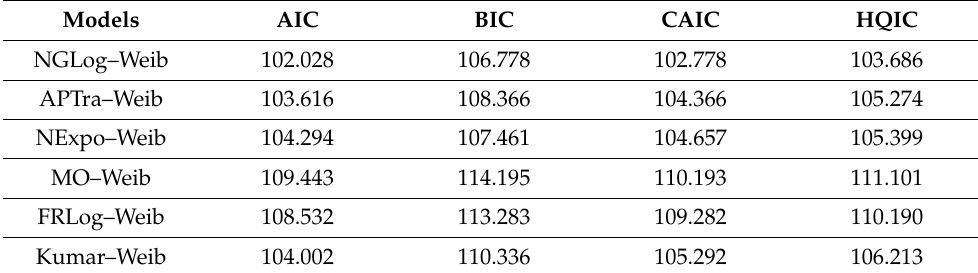
Table 14. The DMs of the competing models for COVID-19 data (dataset 3).